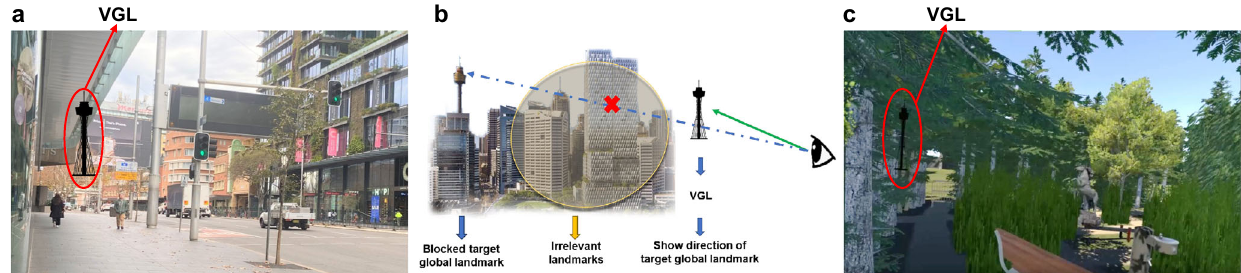
Fig. 1 Design of the VGL system. a First person point-of-view during active navigation in an augmented reality environment. The global landmark is constantly present on the AR glasses and outlined in silhouette when obscured from view. b The working mechanism of the VGL system. As the selected reference of a global landmark is blocked by irrelevant landmarks, the VGL is presented to continuously indicate the direction of target global landmark. c First person point-of-view during active navigation in the fully virtual environment. Again, the global landmark is always present, even when obscured from view by other